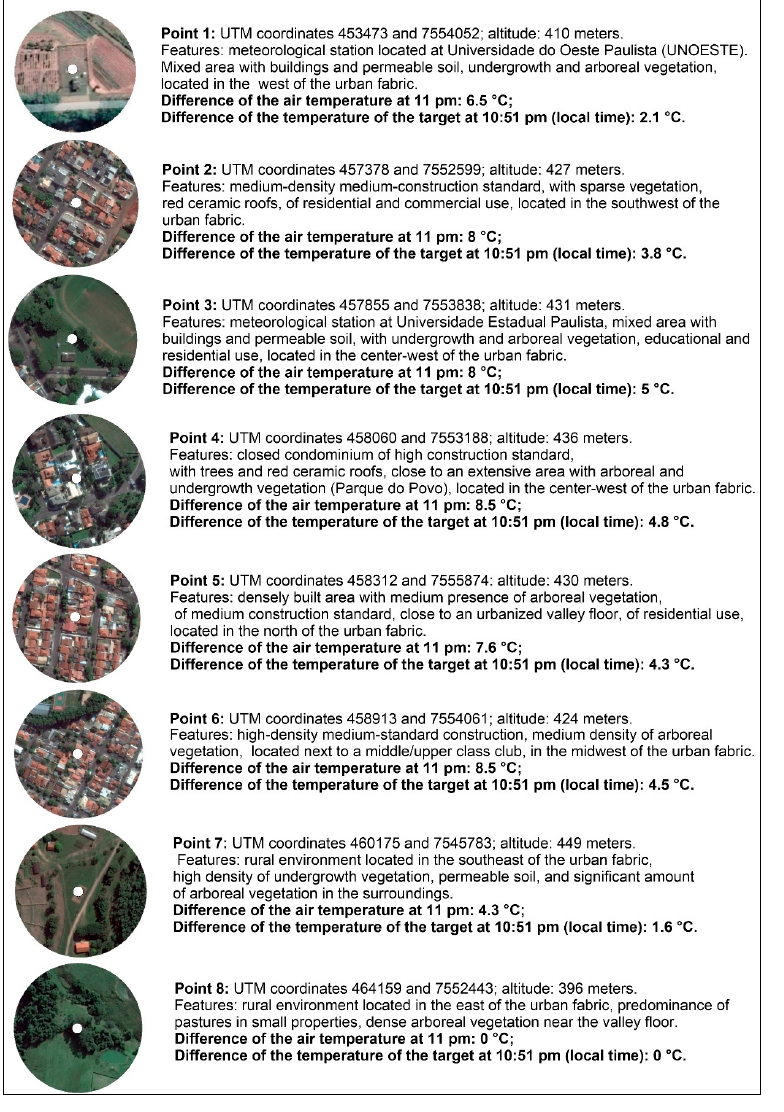
Figure 2. Characteristics of the surroundings of fixed data recording points organized in a west–east direction in Presidente Prudente. Source: Adapted from Amorim (2020) [40]; point 1: Google Earth Maps, 2021. Access: December 2021 [41].